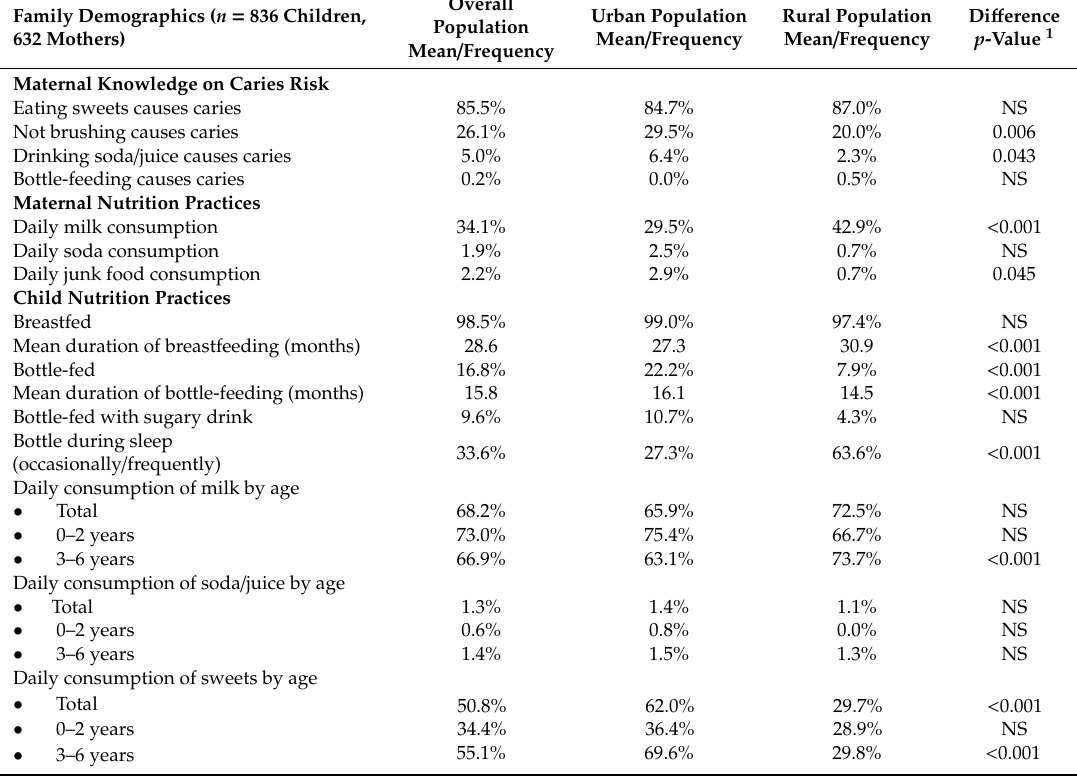
Table 2. Oral health and nutrition knowledge and